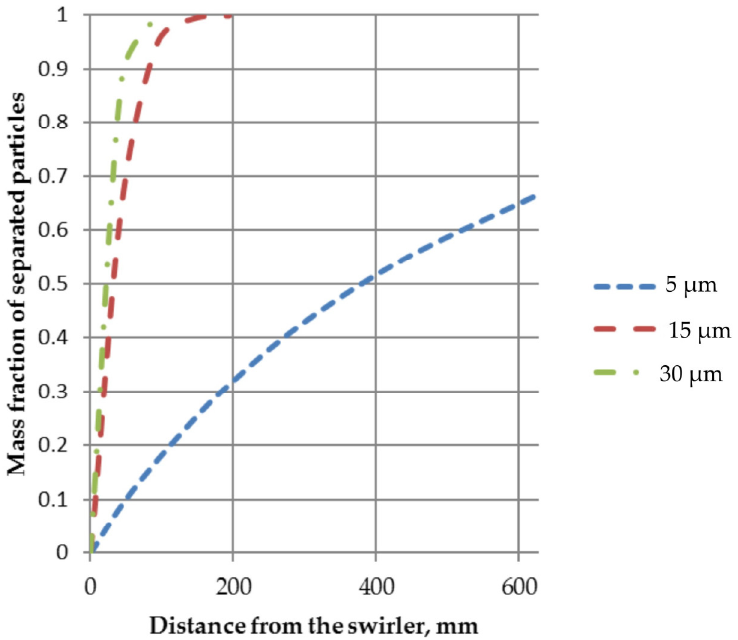
Figure 5. The degree of gas purification at different distances from the swirler during lateral sam- of pling of particles.